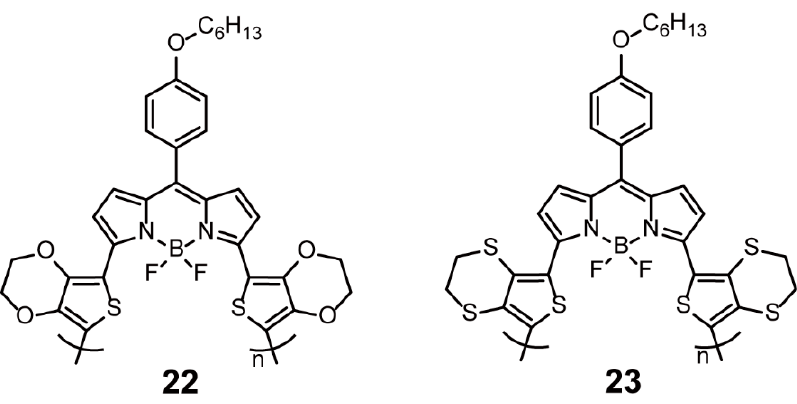
Figure 7. Chemical structures of polymers 22 and 23 (Reproduced with permission from Refer- ence [49]. Copyright @ 2012, Royal Society of